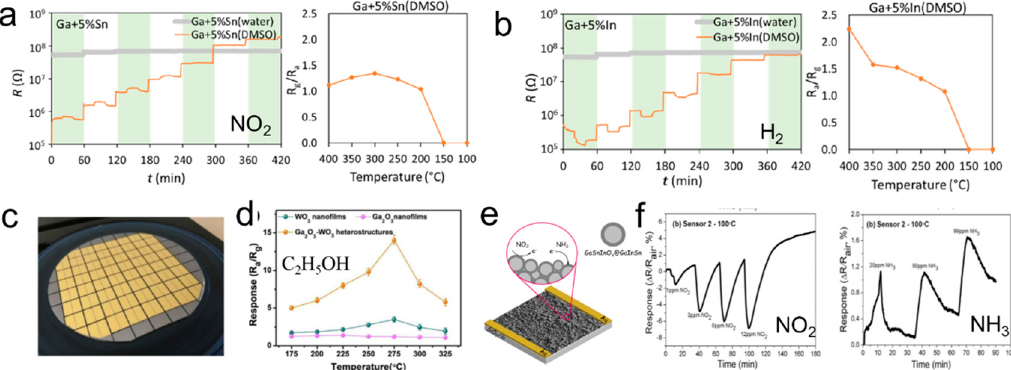
Figure 8. Liquid metal-based gas sensors. ( a ) The response of the sensors to NO 2 gas. ( b ) The response of the sensors to H 2 gas [22]. Copyright (2020) American Chemical Society. ( c ) The optical image of